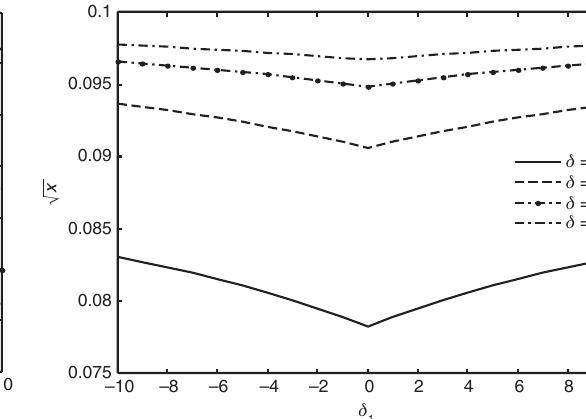
Figure 6: Variations of non-dimensional phase speed ( ) x against = 10; impedance parameter δ 1